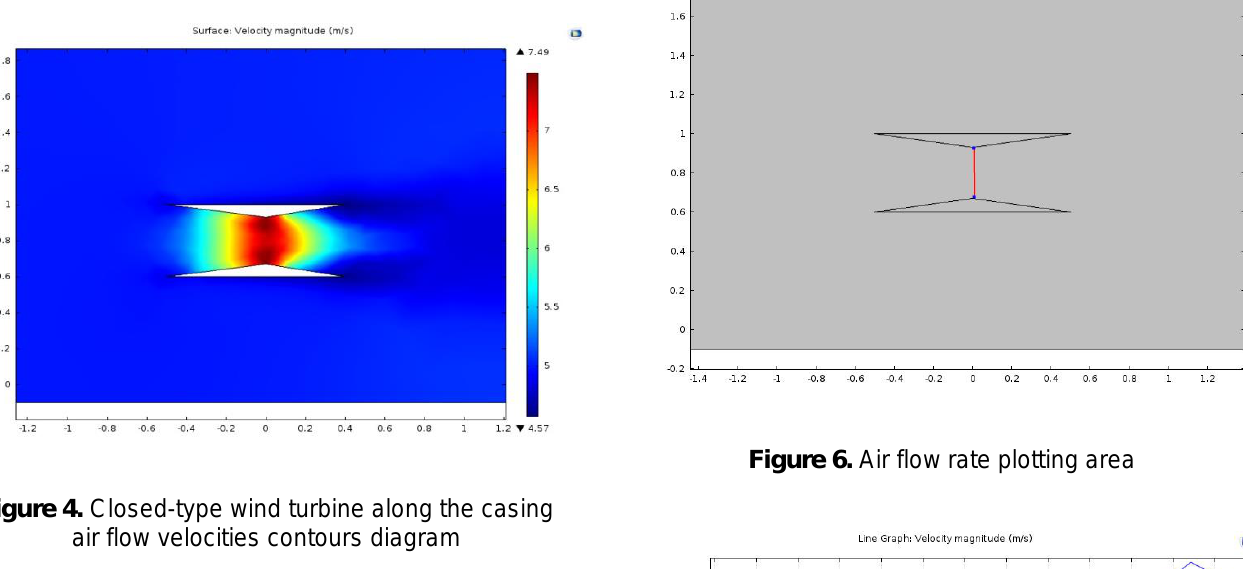
Figure 4. Closed-type wind turbine along the casing air flow velocities contours diagram